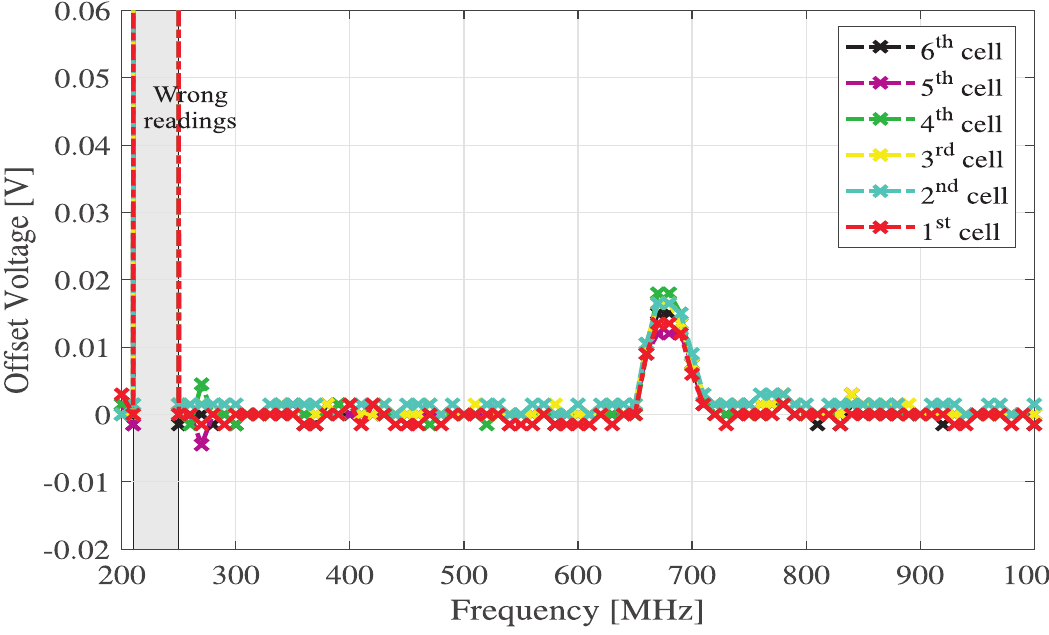
Figure 15. EMI-induced offset in the cell voltage readings. Antenna in front of the cable. Vertical